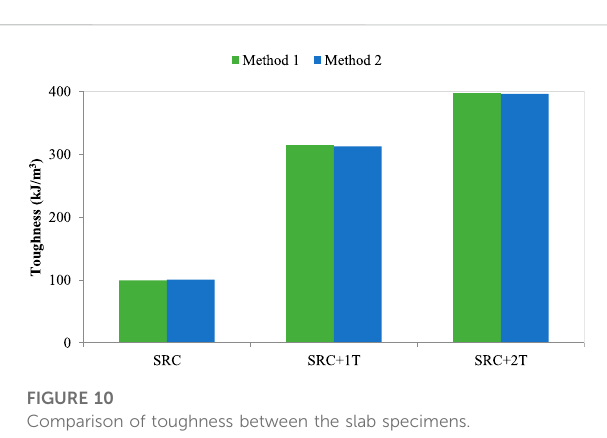
FIGURE 7 Strain pro fi le of slab SRC+1T.